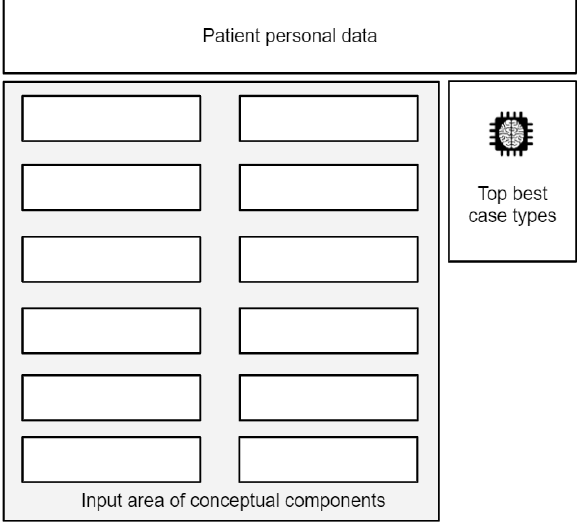
Figure 1. Main features of register